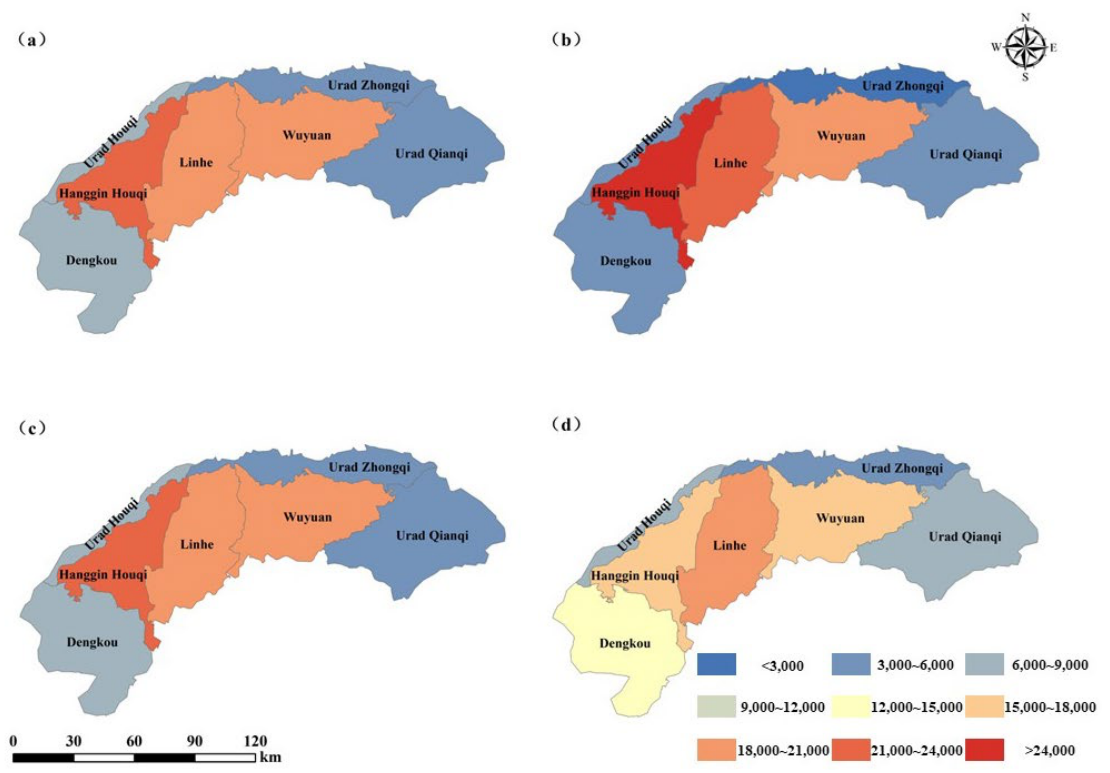
Figure 5. Spatial distribution of NANI in research units of the UNW in 2005–2019 ( a ), 2005–2009 ( b ), 2010–2014 ( c ) and 2015–2019 ( d ).